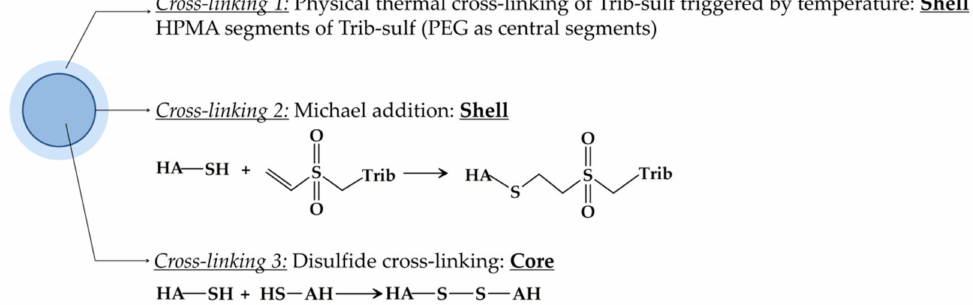
Figure 3. Schematic representation of the novel HA-SH/Trib-sulf NanoC designed in this study. The particle size, PDI and zeta potential of the obtained NanoC and NanoS